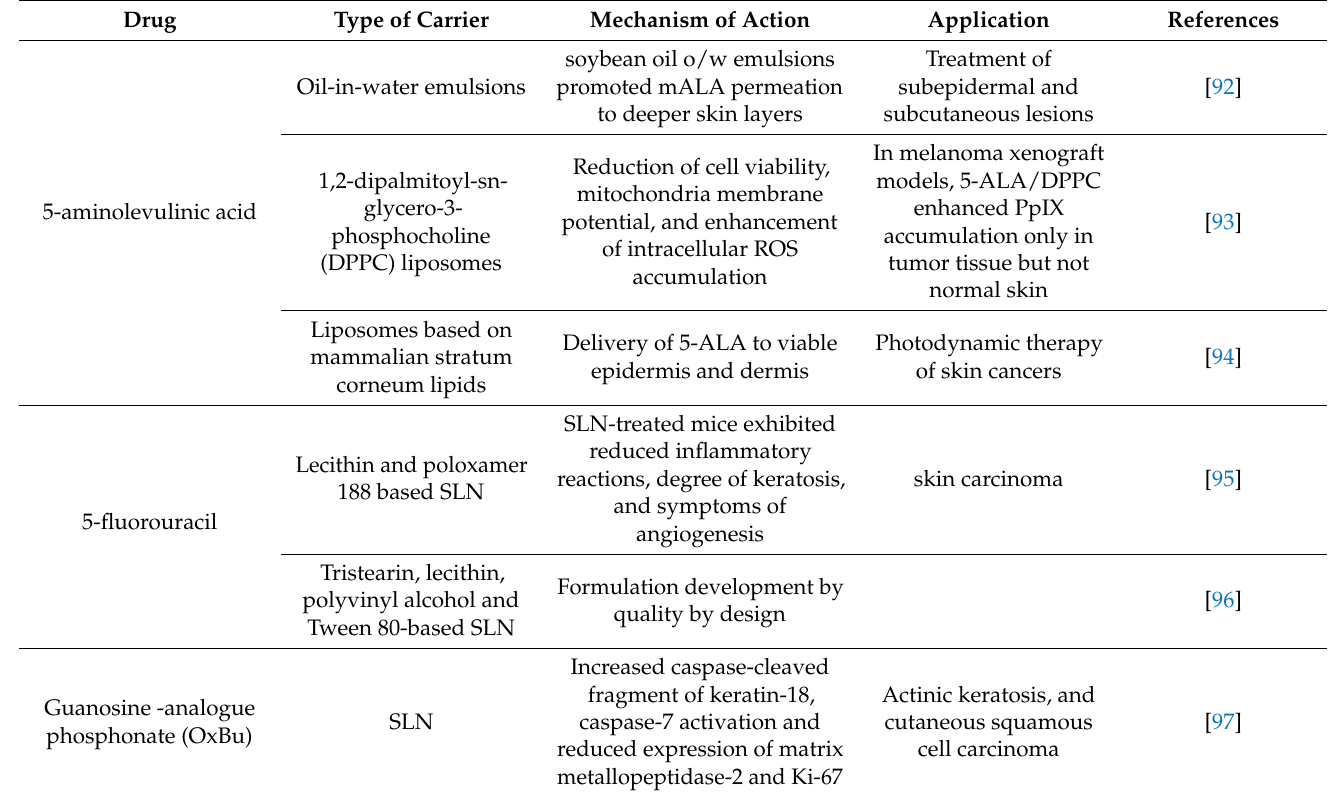
Table 2. Examples of drugs loaded into lipid nanocarriers for the treatment of hyperproliferative diseases.